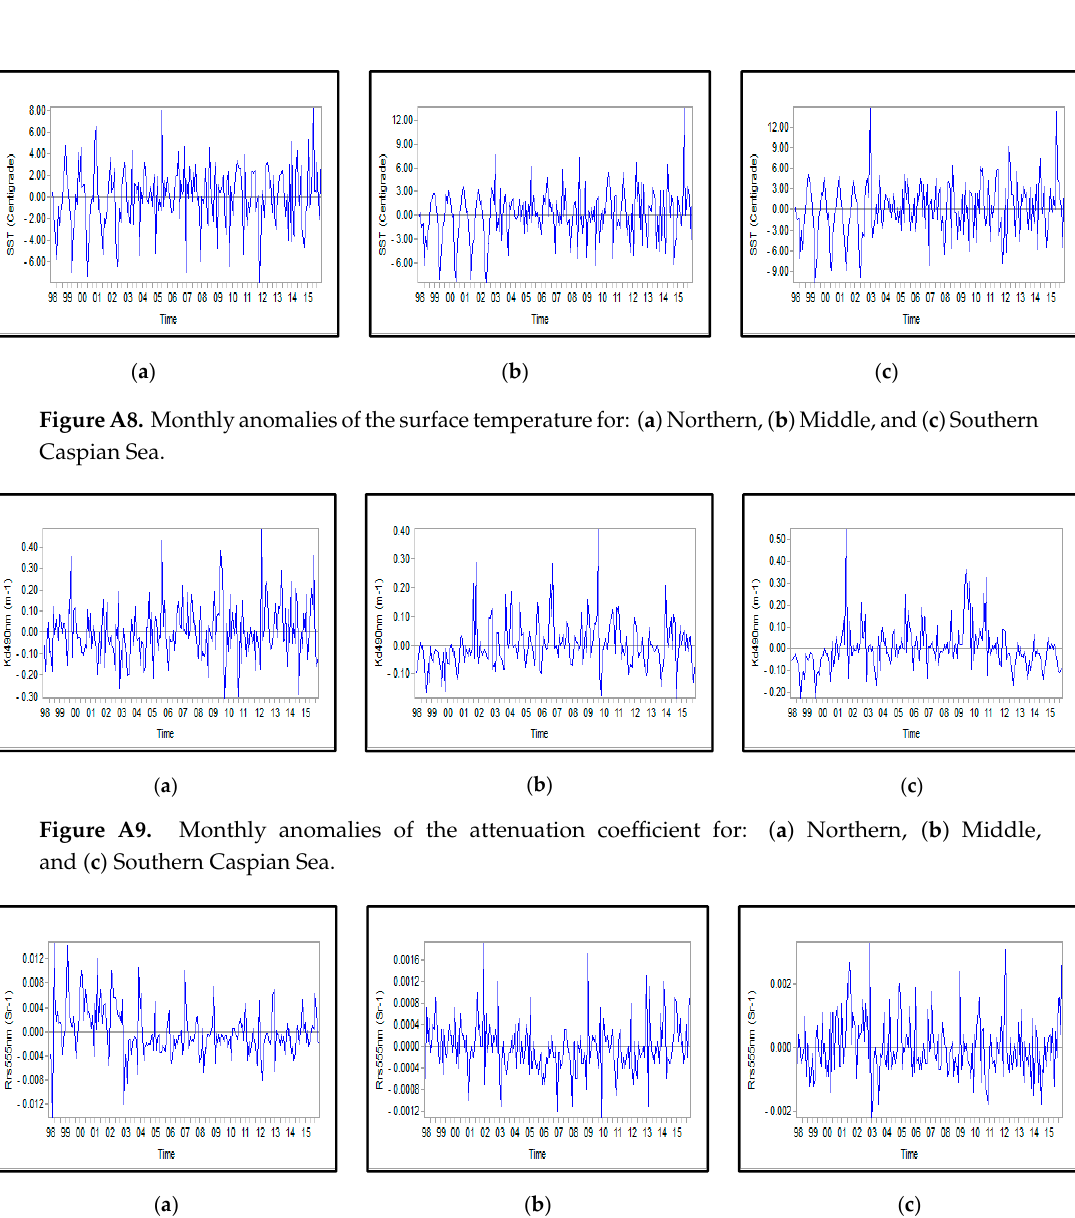
Figure A7. Monthly anomalies of wind stress for: ( a ) Northern, ( b ) Middle, and ( c ) Southern Caspian Sea.